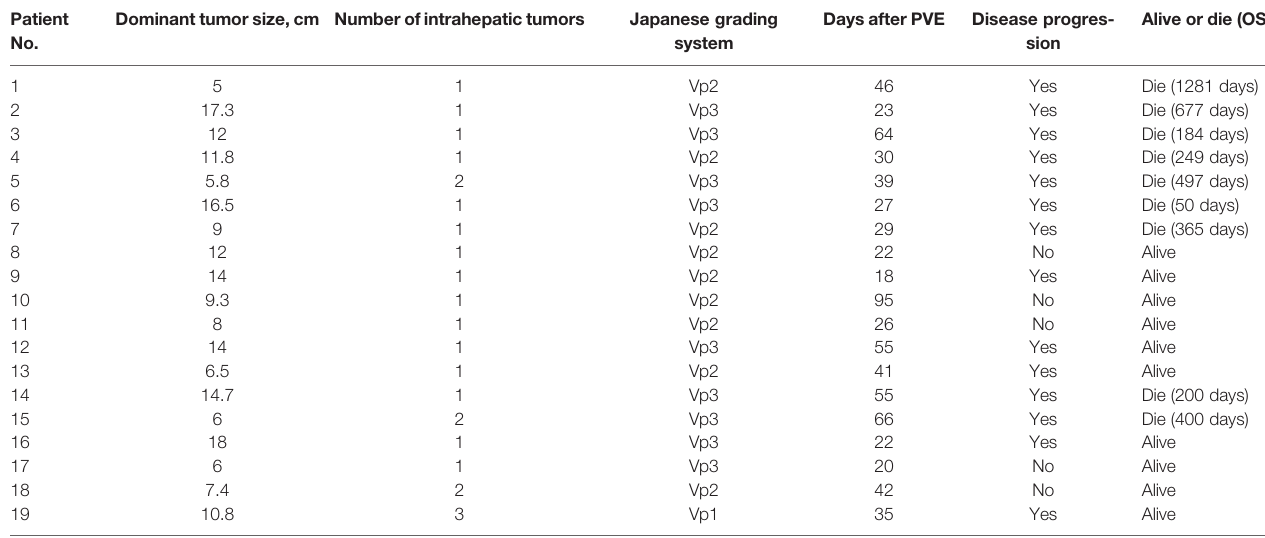
TABLE 2 | Characteristics of surgical and postoperative features. Patient Dominant tumor size, cm Number No.